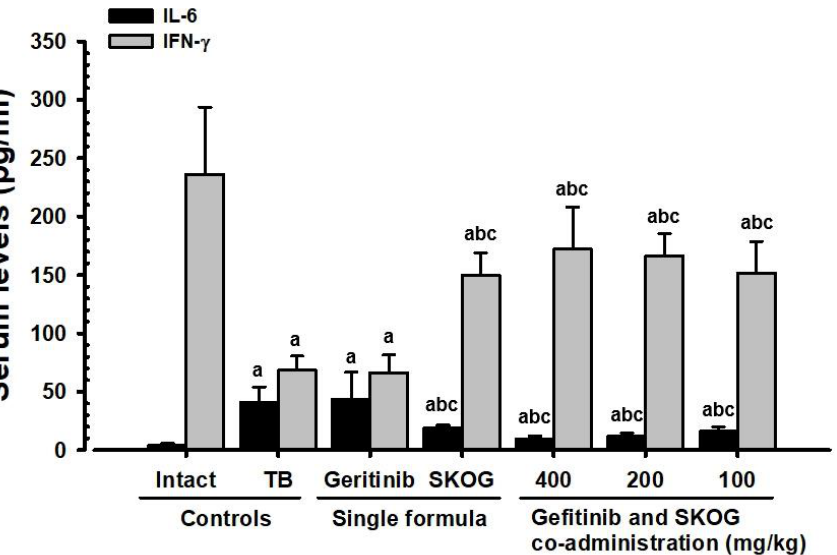
Figure 5. Serum IL-6 and IFN- γ level changes in NCI-H520 tumor cell xenograft mice. AR = Adenophorae Radix; KOG = Kyeongokgo ; SKOG = sasam-Kyeongokgo ; TB = tumor-bearing; IL = interleukin; IFN = interferon. a p < 0.01 versus intact control, assessed by the Mann–Whitney U test; b p < 0.01 versus TB control, assessed by the Mann–Whitney U test; c p < 0.01 versus gefitinib-single-formula-treated rodents, assessed by the Mann–Whitney U test.